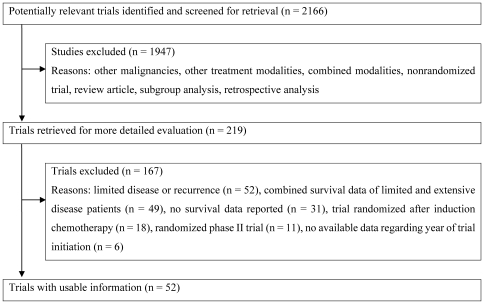
Flow chart showing the progress of trials through the review.